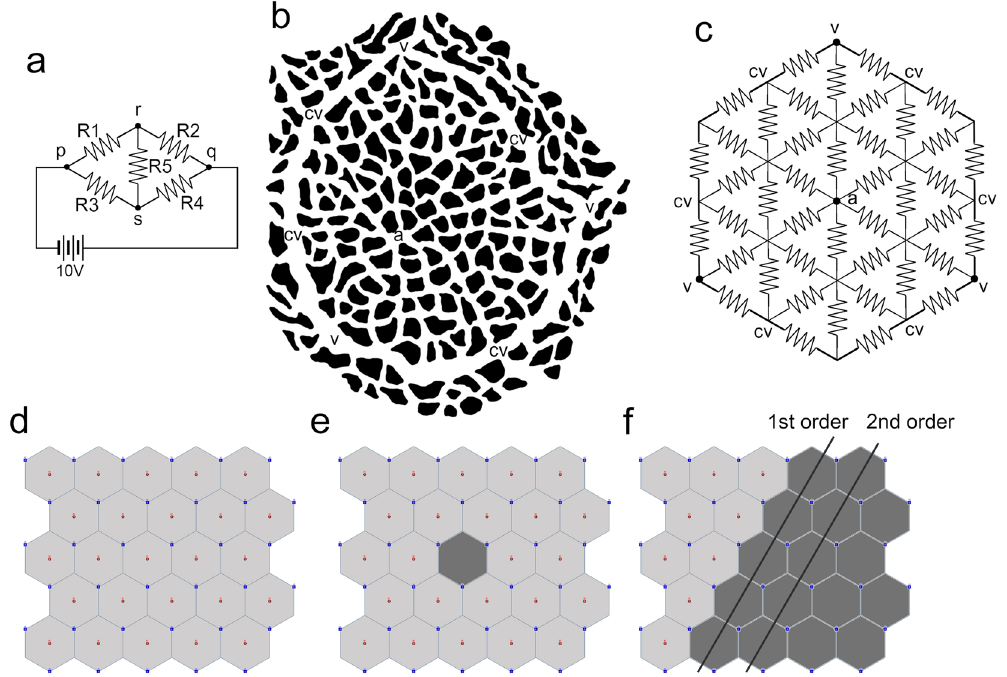
Figure 6. Schematic drawings of the choroidal lobule and its electric circuit model. ( a ) A simple example to explain Kirchhoff’s law. ( b ) The choriocapillaris of the posterior pole is arranged in a lobular pattern surrounded by the collector venules (cv). The feeding arteriole ( * ) joins the choriocapillaris at the center of the lobule. The draining venules (dv) are connected to the periphery of the lobules. ( c ) The electric circuit model of the choroidal lobule is arranged as a dual-layered hexagon. The boundary represents the collector venules (cv), and its electric resistance was set to 1 to 1/16 of the resisters arranged in the inner circuit representing the choriocapillaris. The voltage of the anode ( * ) was set at the center of the hexagon as 50 V. The cathode (dv) was arranged at the periphery of the hexagon representing the draining venules, and its voltage was set as 10 V. ( d ) Hexagons were arrayed as 5 × 5 to represent the choriocapillary bed. ( e ) Disconnecting an anode from one hexagon represents embolism of a single feeding arteriole. ( f ) Disconnecting anodes from a sector of hexagons represents embolism of a posterior ciliary